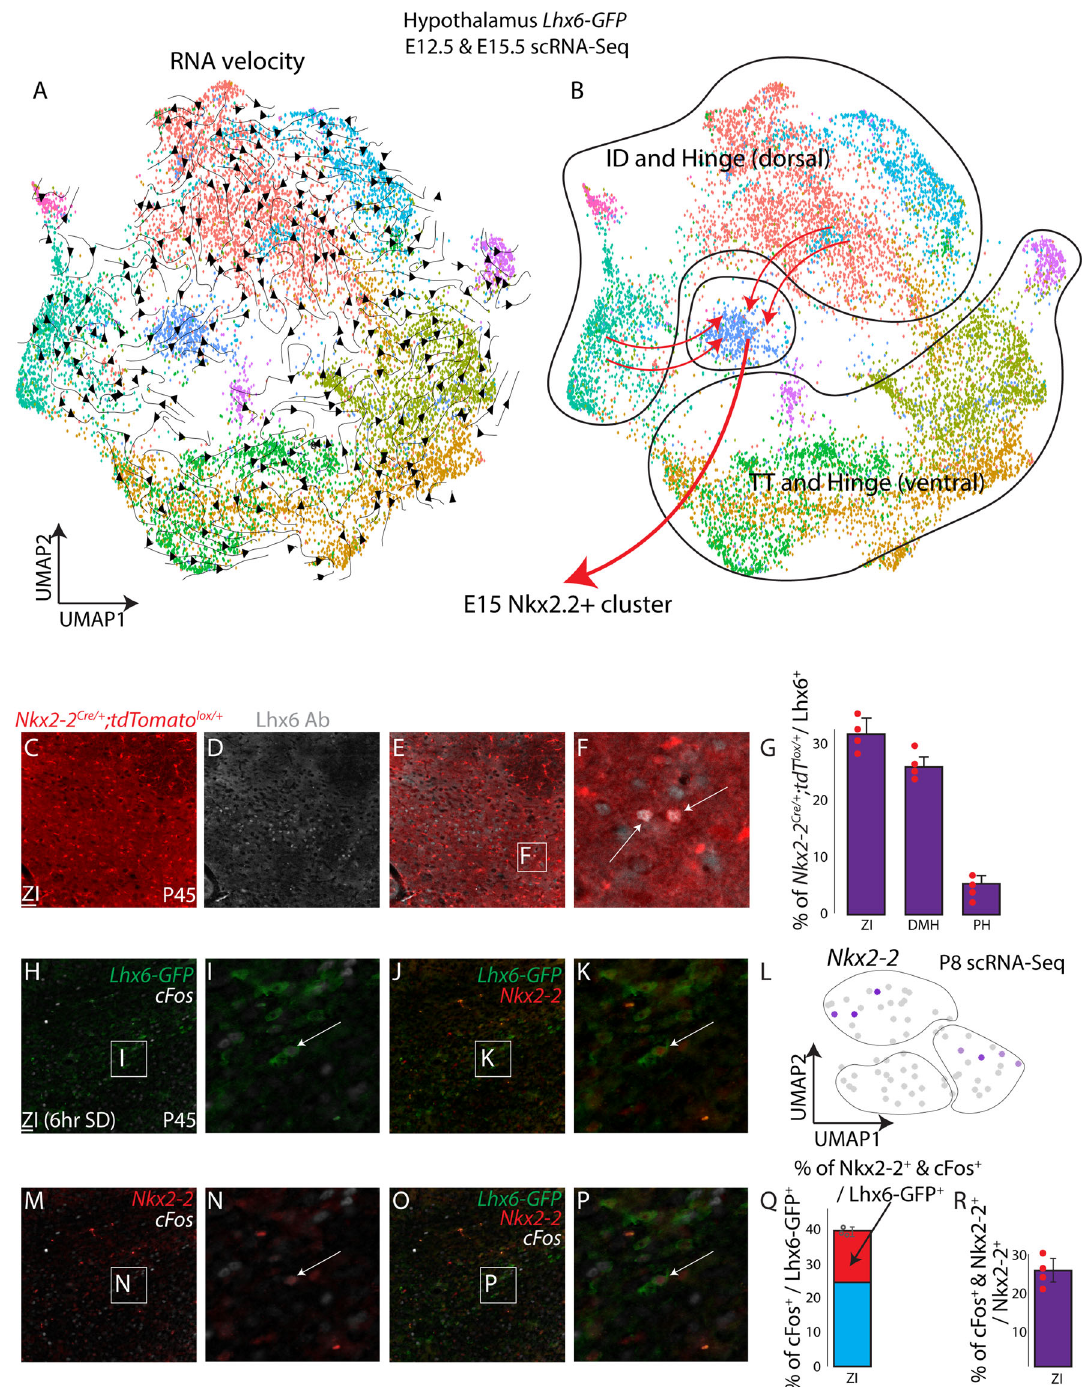
Fig. 7 Nkx2.2-expressing Lhx6 ZI neurons respond to increased sleep pressure. A UMAP plot with RNA velocity trajectories of E12.5 and E15.5 combined scRNA-Seq dataset. B UMAP plot shows distinct domains of hypothalamic Lhx6 neurons. A speci fi c population that continues to express the transcription factor Nkx2-2 is derived from the ID and dorsal hinge region. C – F TdTomato expression in Nkx2-2 Cre/ + ; ;Ai9 mice (red), and Lhx6-antibody staining (gray) identi fi es Lhx6 neurons in the zona incerta (ZI) are derived from Nkx2-2 -expressing precursors. G A bar graph showing the percentage of tdTomato + and Lhx6-expressing neurons relative to the total number of Lhx6-expressing neurons in the ZI, dorsomedial hypothalamus (DMH, Supplementary Fig. 15) and posterior hypothalamus (PH, Supplementary Fig. 15). H – P GFP expression from Lhx6-GFP (green, H – P ), cFos antibody staining (gray) and Nkx2-2 antibody staining (red) shows a speci fi c population of Nkx2-2 + Lhx6 neurons in ZI that selectively responds to sleep pressure. L UMAP plot showing Nkx2-2 expression in the anterior portion of Lhx6 neurons. Q A bar graph showing the percentage of cFos + and Lhx6-GFP + neurons relative to the total number of Lhx6-GFP + neurons, and demonstrates that a subset of sleep pressure-responsive Lhx6 neurons express Nkx2-2. R A bar graph showing the percentage of cFos + and Nkx2-2 + neurons relative to the total number of Nkx2-2 + neurons, and that a subset of sleep-pressure responding Lhx6 neurons express Nkx2- 2. Scale bar = 100 μ m. All bar graphs ( G , Q , R ) show mean and standard error of the mean (SEM), with individual data points plotted.